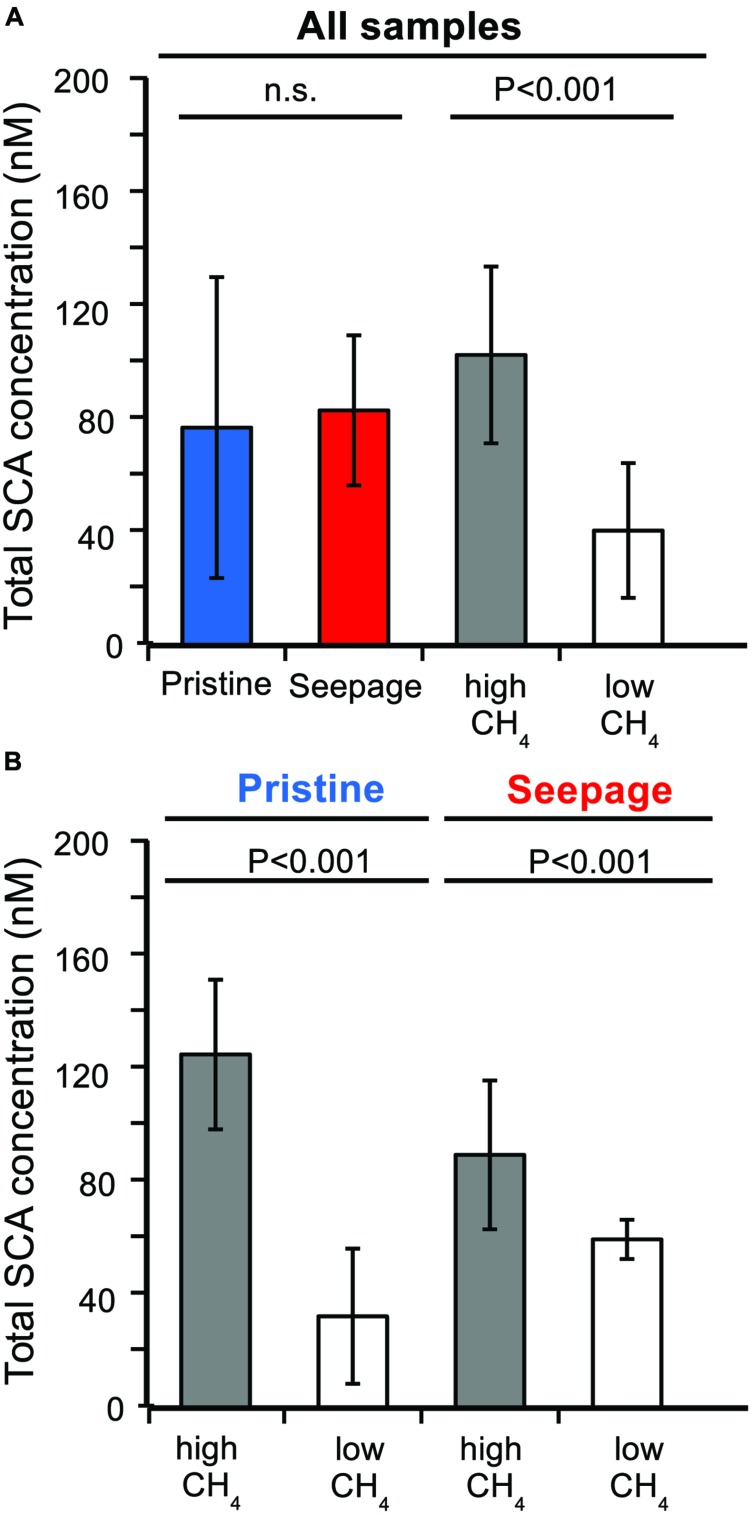
Average total SCA concentrations in pristine and seepage-impacted sediments. (A) Comparison based on all samples grouped according to sediment type (pristine vs. seepage) and methane concentrations (high: LF1, LF4, SKA5, M5; low: BB, SKA1, SKA3, SKA4). (B) Separate comparisons for pristine and seepage sediments, respectively. P-values are indicate based on Student’s t-test. n.s., not significant (P > 0.05).